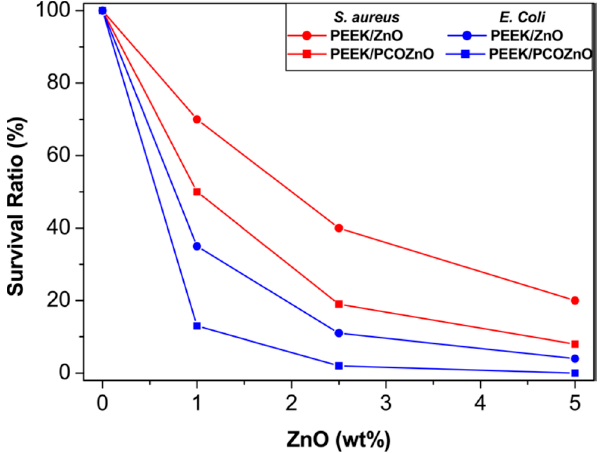
Figure 22. Antibacterial activity of PEEK/ZnO and modified PEEK/ZnO nanocomposites as a function of ZnO content. Reproduced from [179] with permission of American Chemical Society.